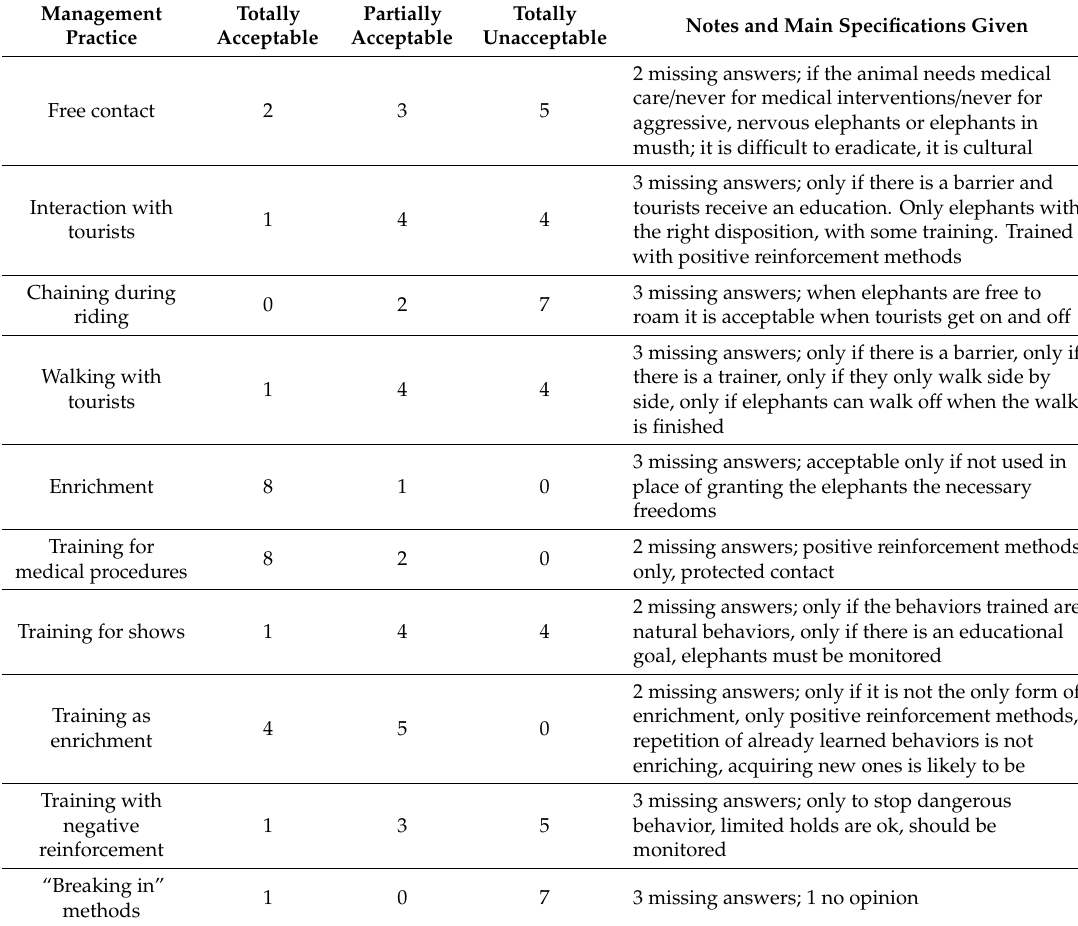
Table 3. Results of the acceptability